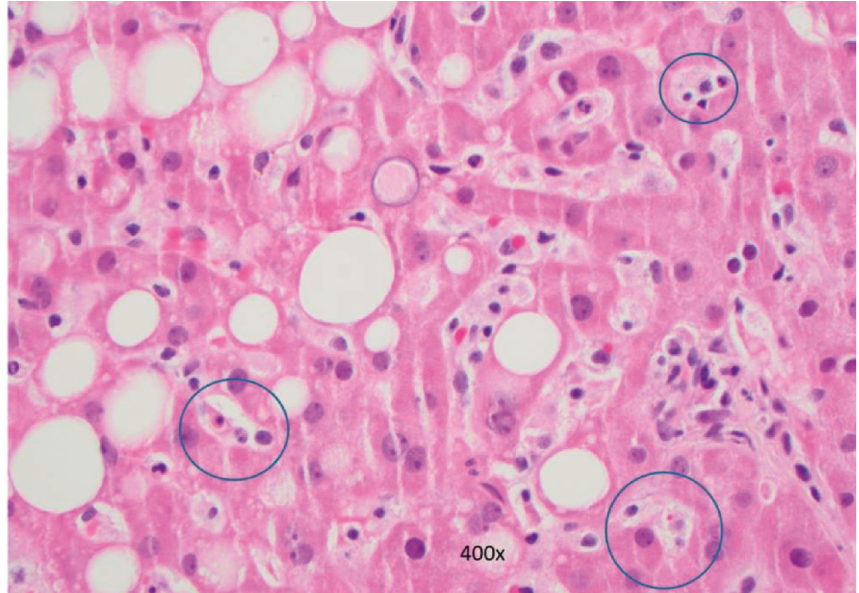
Figure 5: Sinusoidal histiocytic hemophagocytosis. H&E stain of liver tissue. Examples of mature red cells within histiocyte cytoplasm as well as probable degenerate neutrophils within histiocytes are circled. Original magnification,